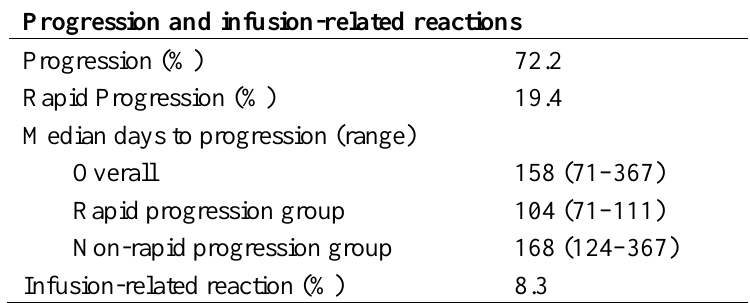
Table 2. Progression and infusion-related reactions in patients after receiving sipuleucel-T.